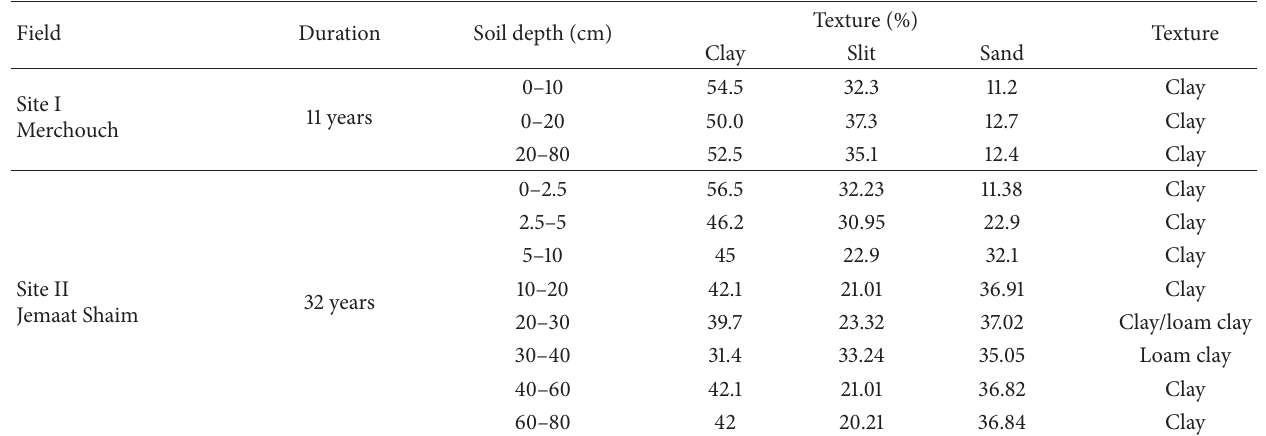
Table 1: So1l texture characteristics at the soil profile for the both sites.